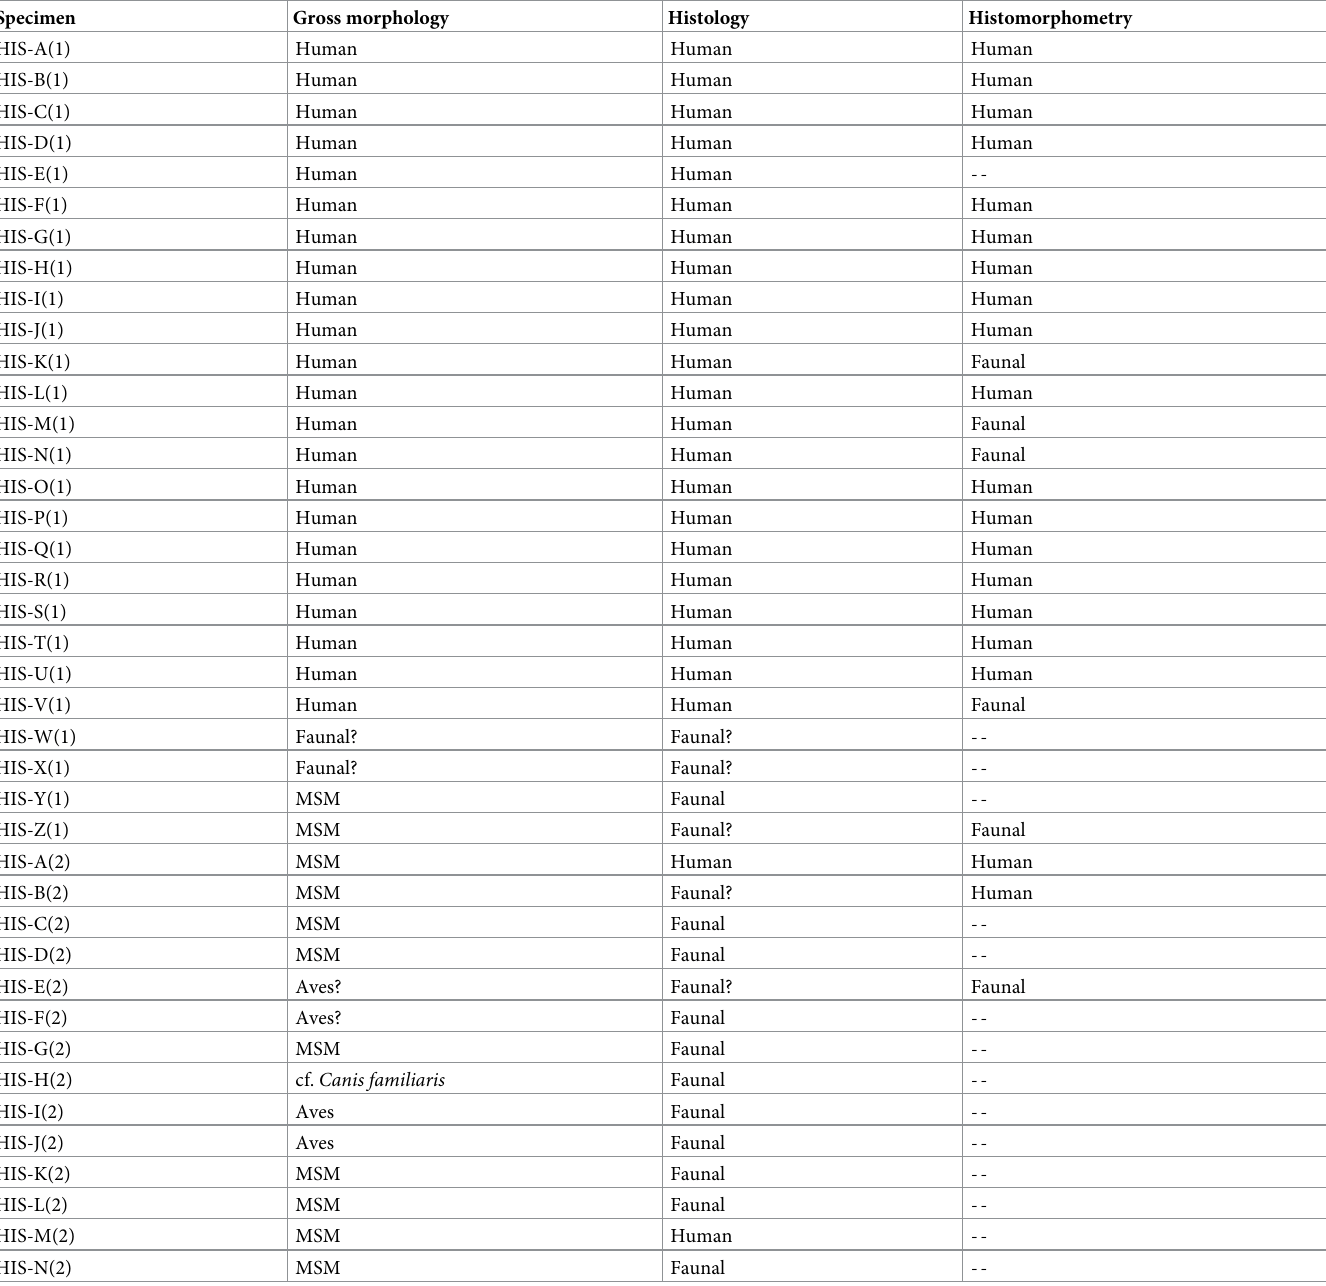
Table 3. Gross morphology, histology, and histomorphometry comparison in the selected sample from the Tomb of Nestor’s